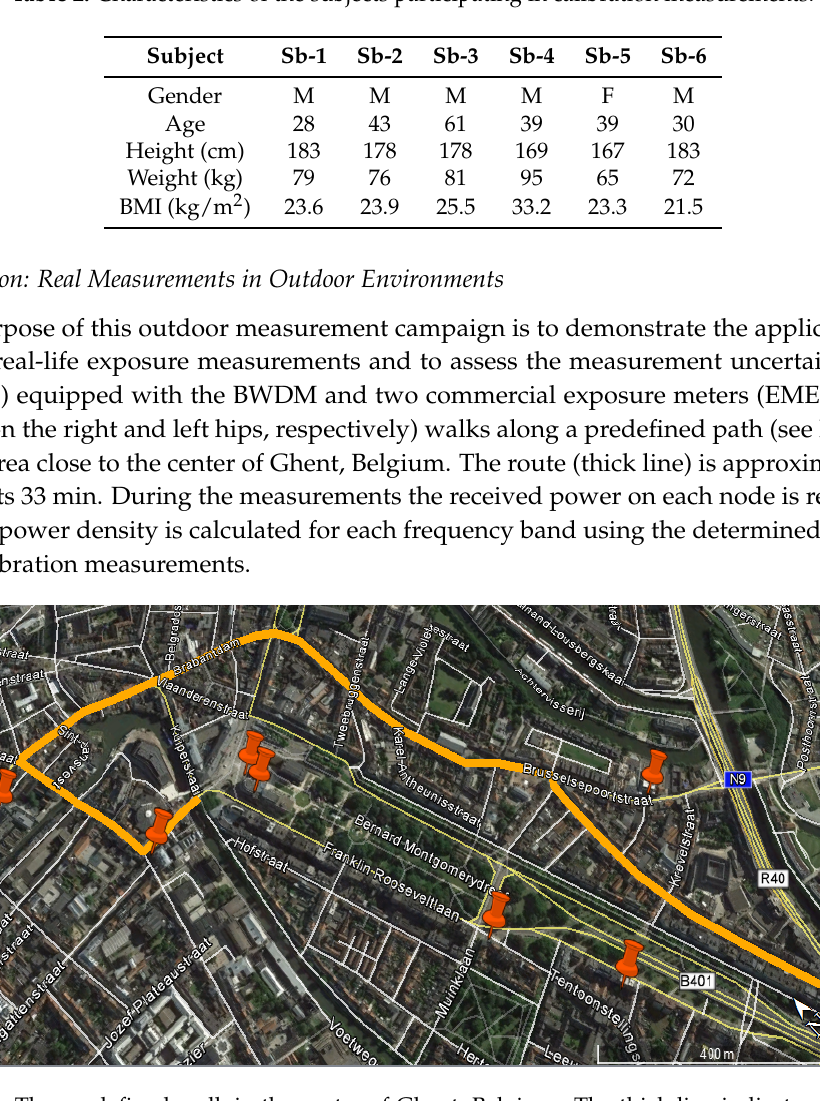
Figure 5. The predefined walk in the center of Ghent, Belgium. The thick line indicates the route. The orange place markers indicate the location of antennas. (The location of antennas are extracted from